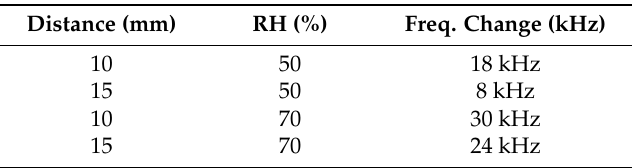
Table 2. Resonance frequency of the reader while coupling the wireless sensor at the minimum (20 ◦ C) and maximum (50 ◦ C) temperature tested for different distances.